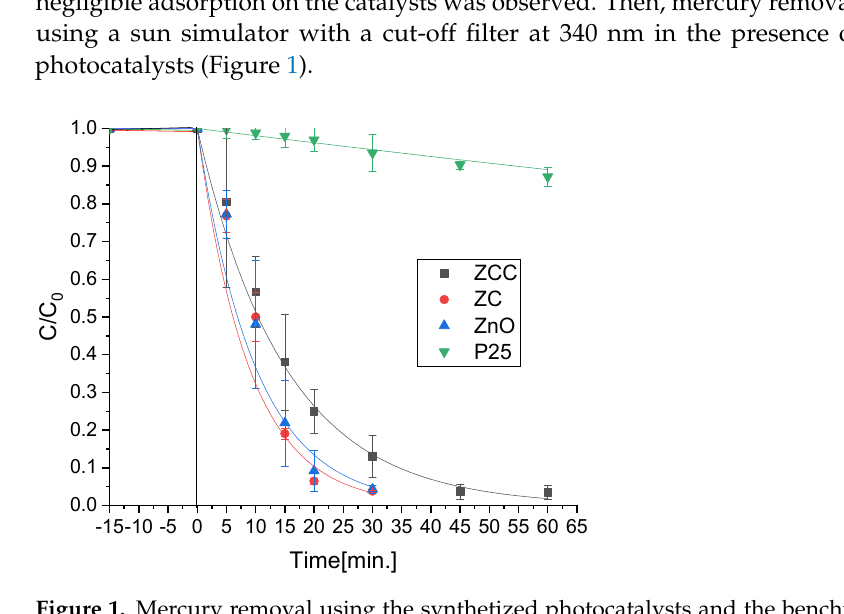
Figure 1. Mercury removal using the synthetized photocatalysts and the benchmark Evonik P25 under irradiation in a solar light simulator, after N 2 stripping and 15 min of equilibration in the